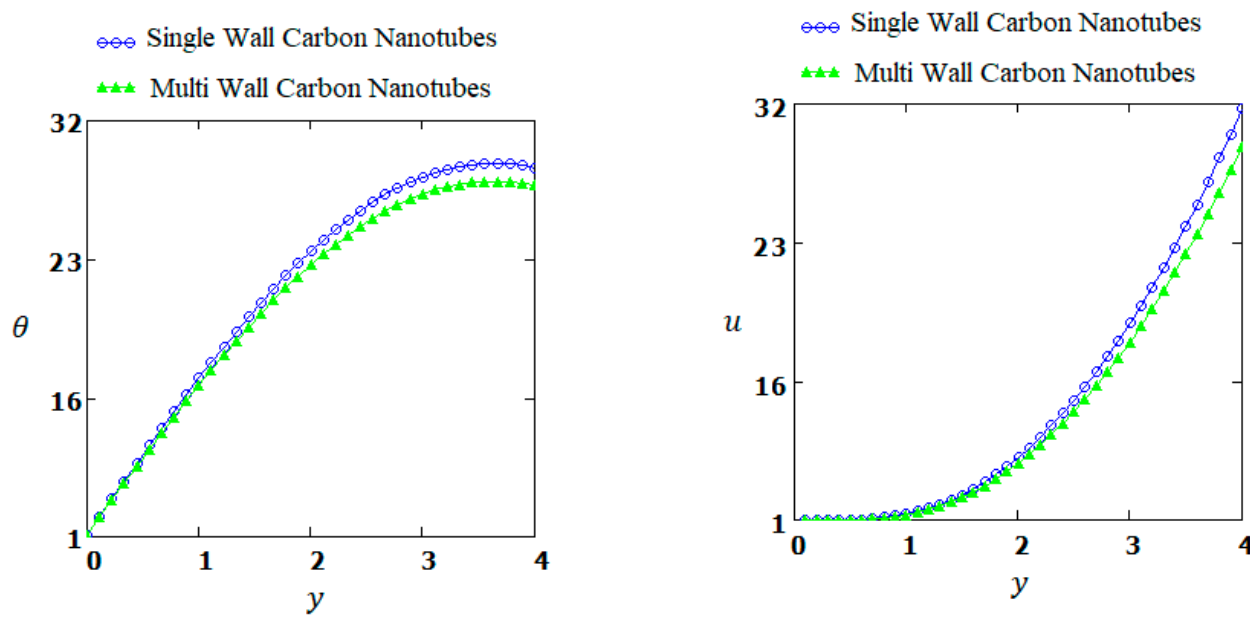
Figure 7. Temperature distribution and velocity profile of single and multi-wall carbon nanotubes without ripple visualizations for 2-D graphs.